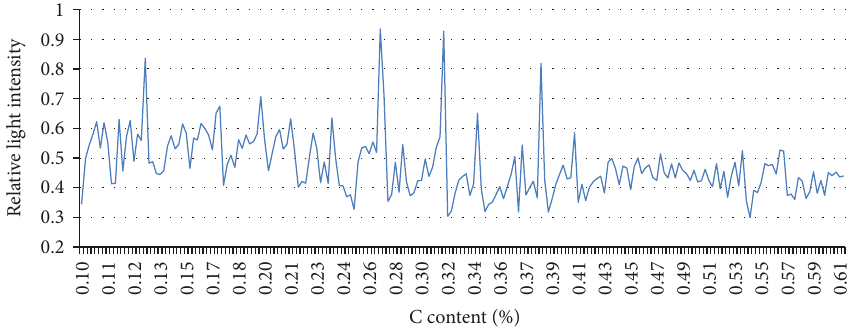
Figure 8: The signal diagram of the converter 6C00582 with relative intensity as the original signal.